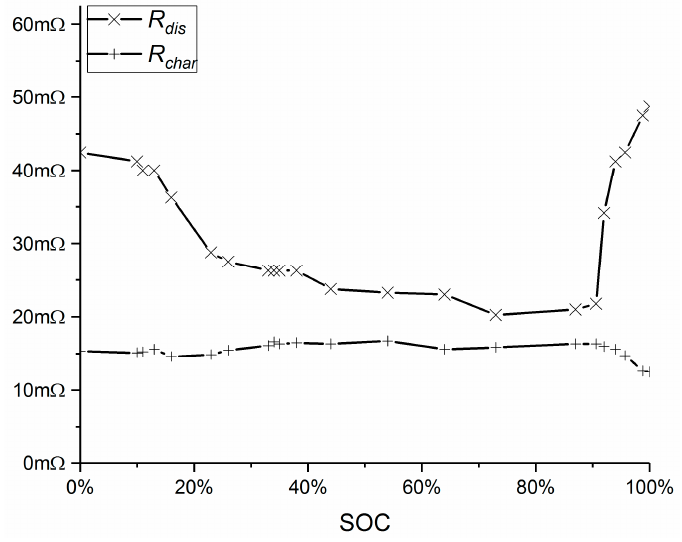
Figure 12. Rint model, charge and discharge resistors in dependence on SOC.